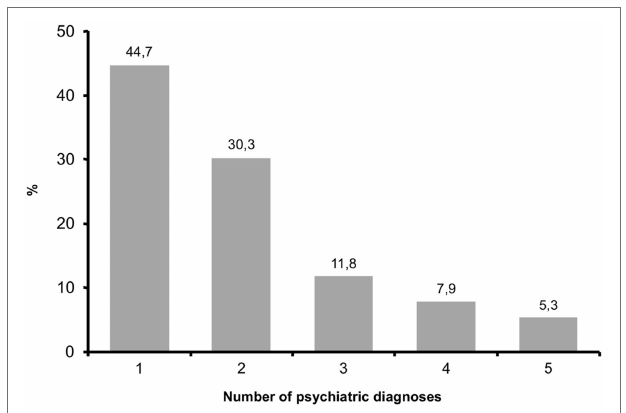
FIGURE 1 | Number of patients’ psychiatric diagnoses ( N = 76).